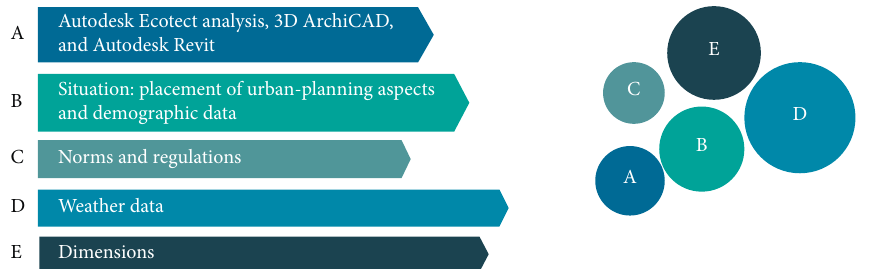
Figure 5: Conceptual and simulation phases design related